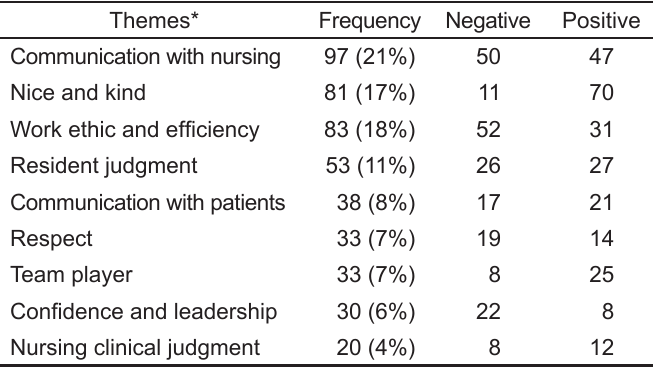
Table 2. Qualitative themes and frequency of each theme in nurses’ assessments of emergency medicine